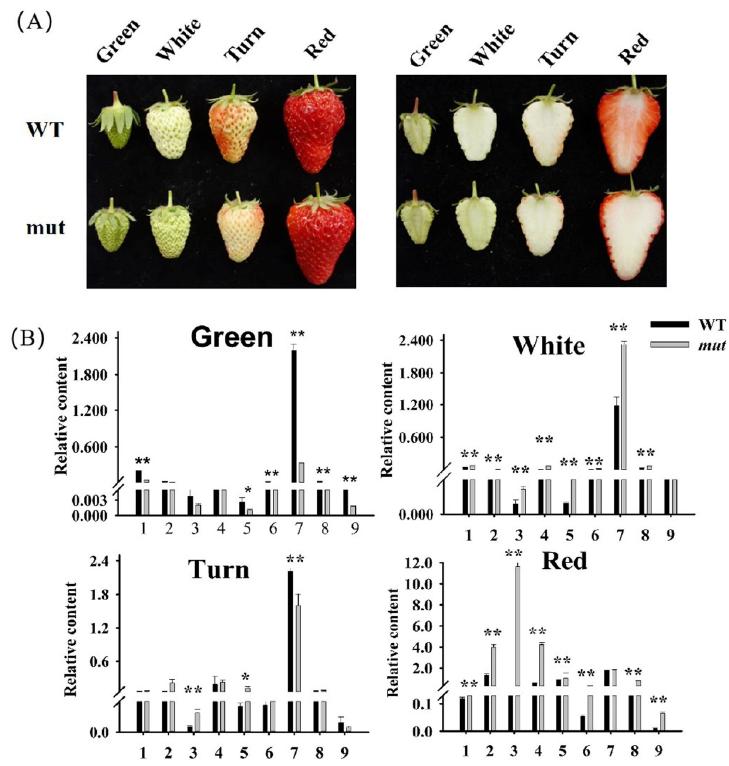
Figure 1. ( A ) Fruit phenotype in four developmental stages of ‘Benihoppe’ and ‘Xiaobai’; ( B )